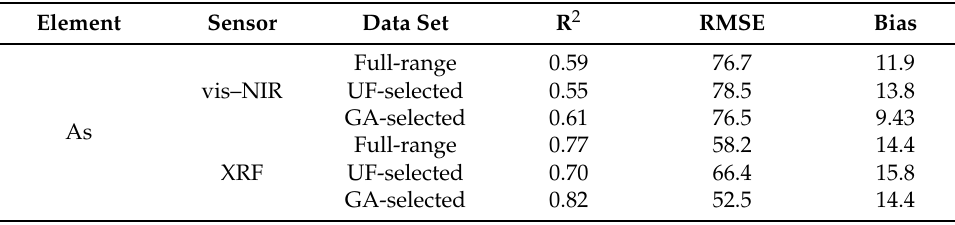
Table 2. Statistics of the prediction model performance for soil PTEs concentration (mg/kg) using the single spectrometers’ full-range and feature-selected spectra (validation data